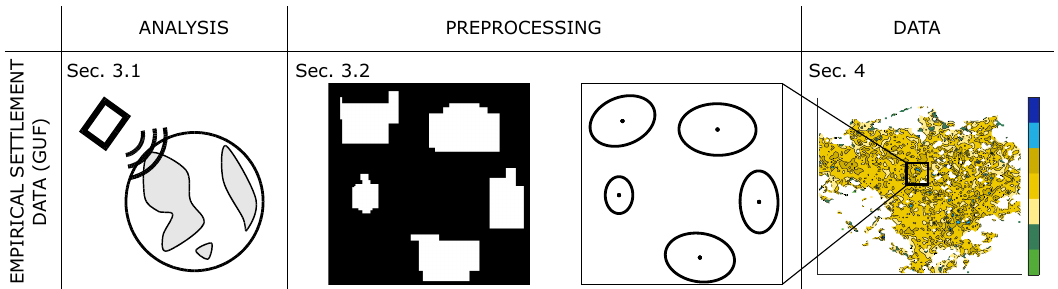
Figure 1. Types of pattern classified by number of objects, density and regularity.